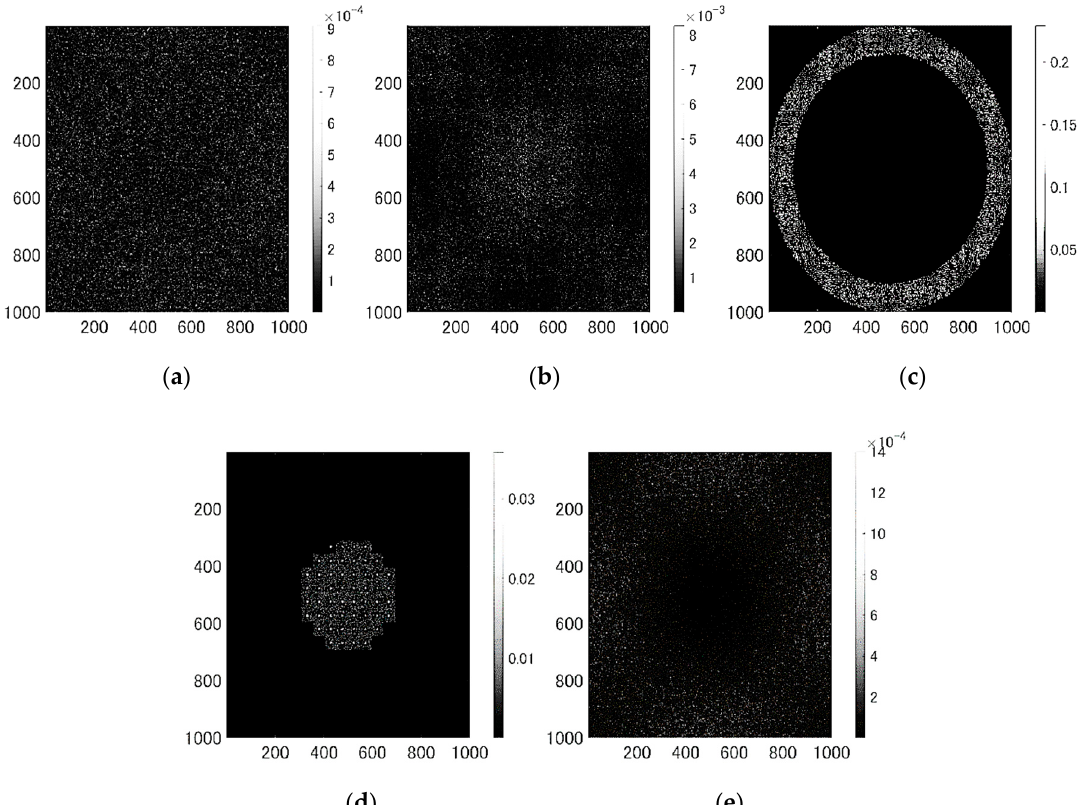
Figure 7. Each intensity distribution on the reconstructed image plane calculated by separating only each order diffracted light, ( a ) (cid:3398)2 nd ‐ order; ( b ) (cid:3398)1 st ‐ order; ( c ) 0 th ‐ order; ( d ) (cid:3397)1 st ‐ order; ( e ) (cid:3397)2 nd ‐ order.